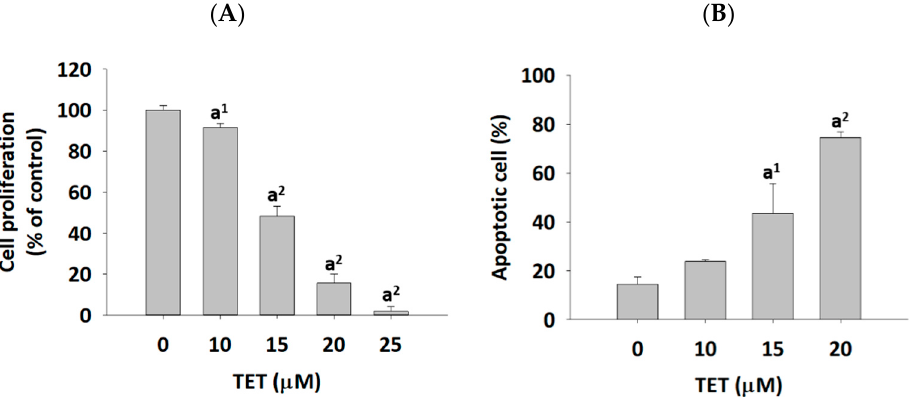
Figure 1. The effect of TET on cell viability and apoptosis in GBM 8401/ luc2 cells. Cells (1 × 10 5 cells/well) were incubated with TET (0, 10, 15, 20, and 25 μ M) for 48 h, and cells were harvested and measured for cell viability ( A ) and apoptosis ( B ) using a flow cytometer as described in Materials and Methods. Data are expressed as mean ± standard error. Comparisons between control and TET-treated groups were performed using one-way ANOVA. (a 1 p < 0.05 and a 2 p < 0.01 vs. control).